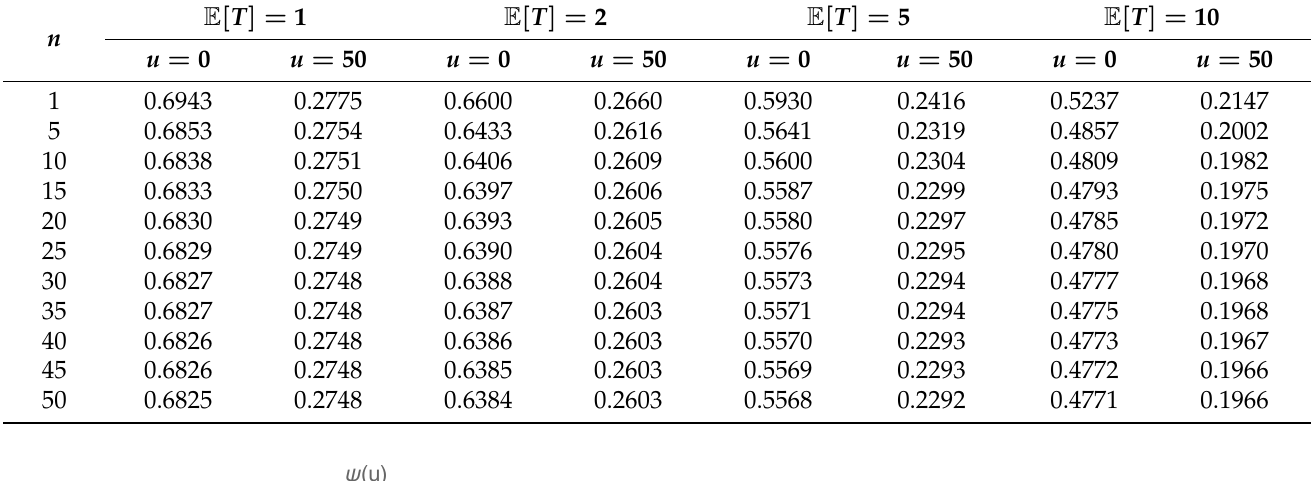
Table 4. Modified Parisian ruin probabilities when claims are a mixture of exponentials.